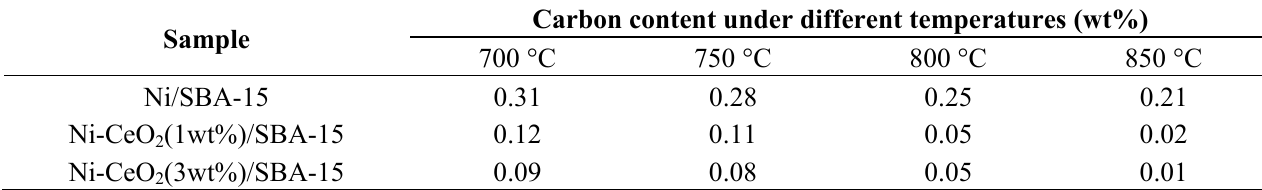
Table 2. Carbon contents of the three used catalysts under different reaction